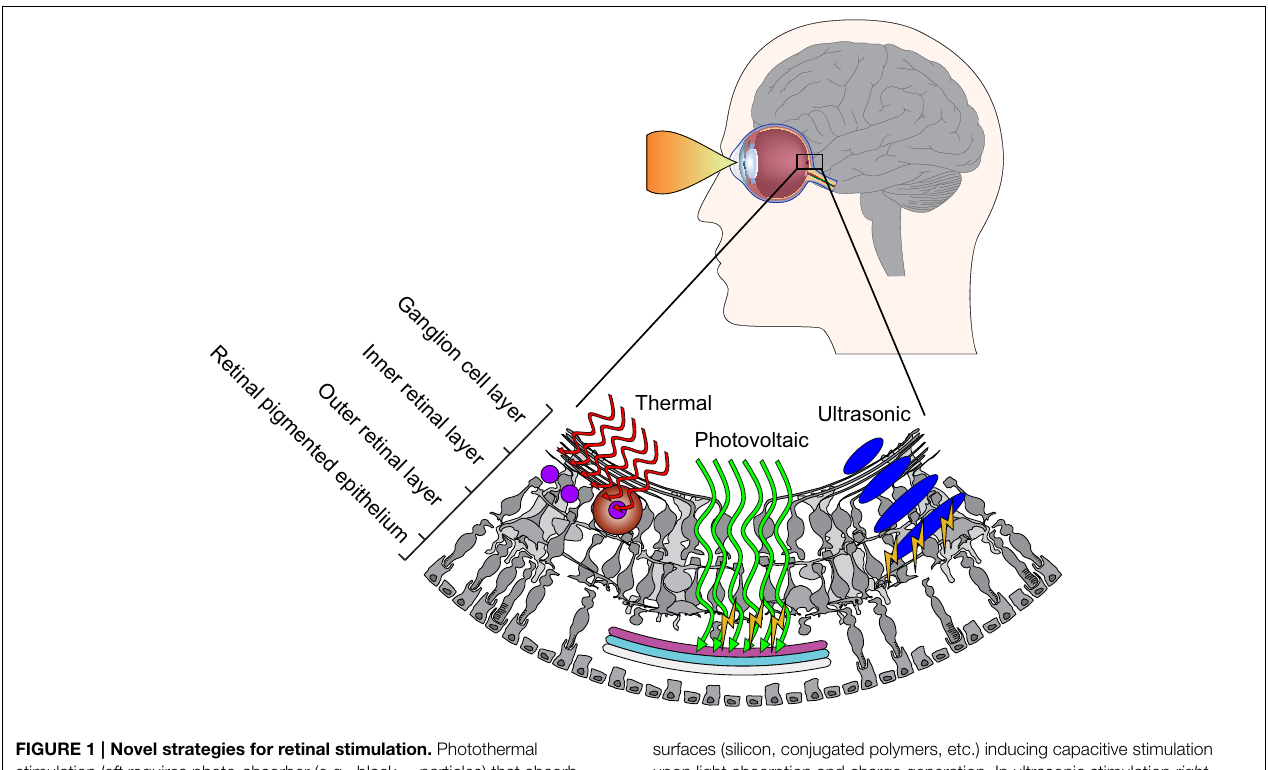
surfaces (silicon, conjugated polymers, etc.) inducing capacitive stimulation upon light absorption and charge generation. In ultrasonic stimulation right , ultrasonic waves are transmitted into the eye and interfere to create a projected pattern for exciting retinal